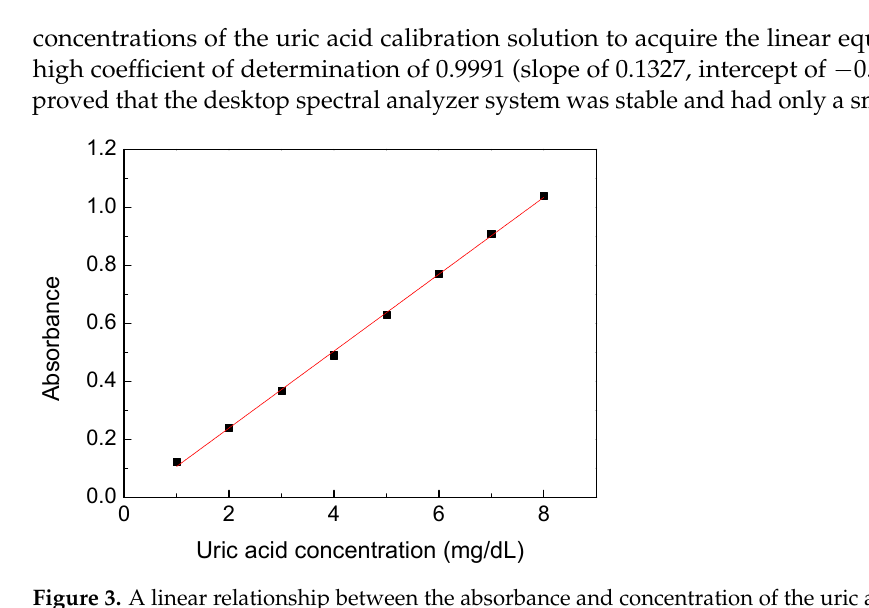
Figure 3. A linear relationship between the absorbance and concentration of the uric acid calibration solution at wavelength 300 nm.